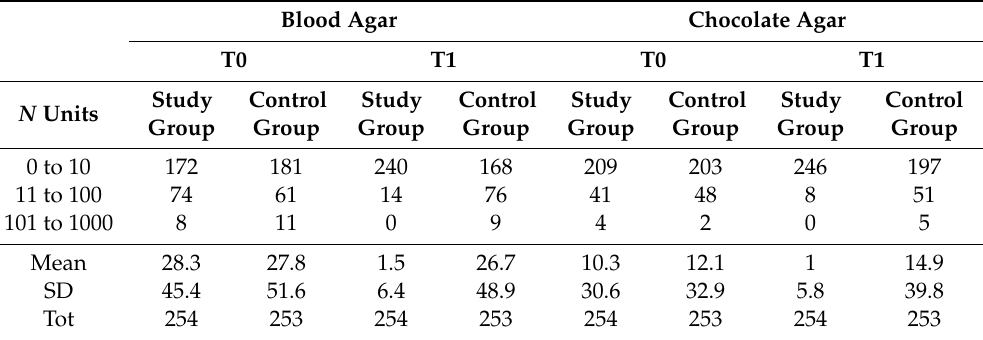
Table 2. Colony forming units on blood agar and chocolate agar